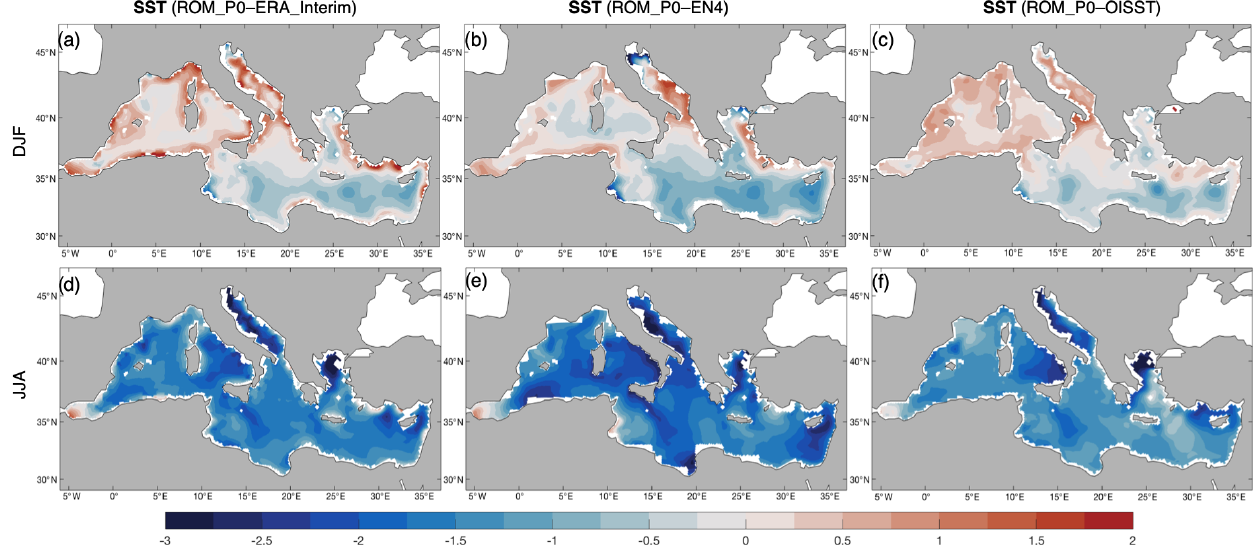
Figure 5. SST differences between ROM_P0 ( ◦ C) and the different climatologies (ERA-Interim a , d ; EN4 b , e ; and OISST e , f ) in winter (DJF a, b, c ) and summer (JJA d, e, f ).